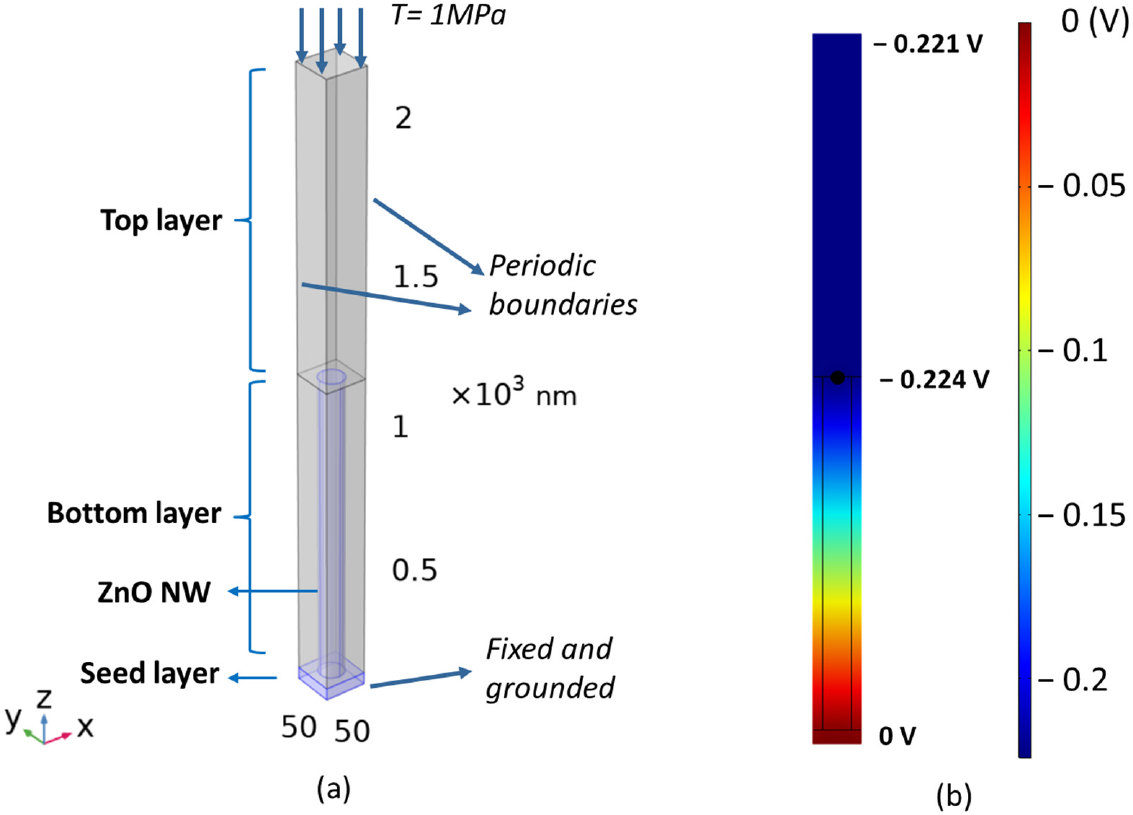
Figure 4. COMSOL model of ZnO NW: ( a ) schematic structure of a unit cell consisting of ZnO SL, bottom matrix layer, top matrix layer, and single ZnO NW with proper boundary conditions; ( b ) electric potential longitudinal profile of unit cell subjected to an axial compression (viewed in 2D YZ cut plane).